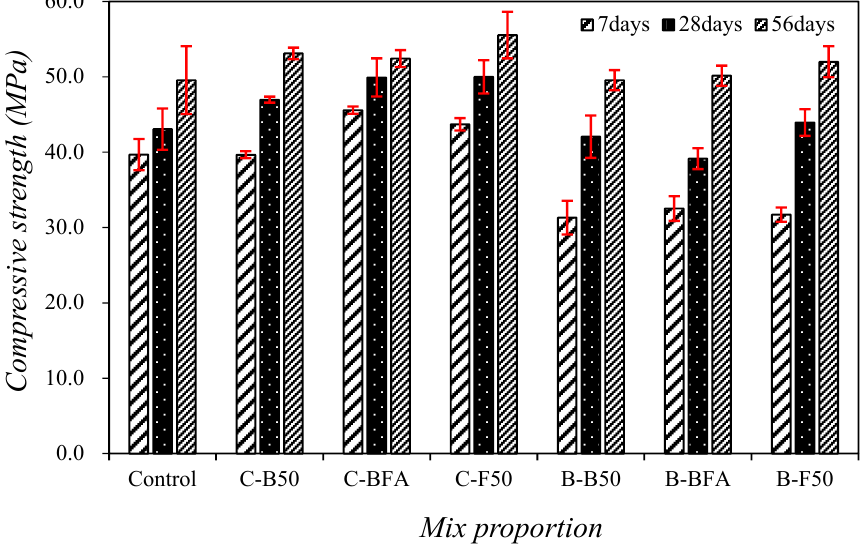
Figure 5. Changes in compressive strength of the mortar with mixed fine aggregate.